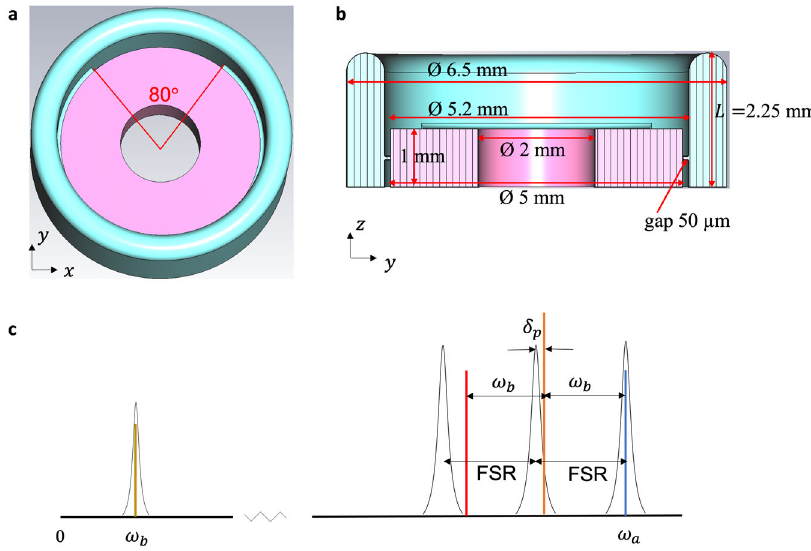
Fig. 1 Three-dimensional superconducting RF (SRF) cavity and electro-optic design for quantum transduction. a Top view of the SRF cavity enclosing a bulk lithium niobate (LN) optical resonator (pink). The cyan region refers to the vacuum volume enclosed by the niobium (Nb) (not visible). The LN resonator has a hole (grey) in the center with a 2 mm diameter which is fi lled with Nb. b Side view of the cross- section of the RF cavity with the enclosed LN resonator. L is the length of the stub, which is used to tune the resonant frequency. c Diagram of the three-wave mixing process for microwave-optical quantum transduction. The optical pump is injected into the optical resonator. The pump is detuned by δ p from the central optical mode. Mixing of the optical pump and the weak microwave signal at frequency ω b generates two optical sidebands (red and blue). The blue sideband signal excites the optical mode at ω a , whereas the red sideband signal is off- resonance and inhibited. Reversely, by mixing the optical pump and the optical signal at ω a , microwave photons at ω b are coherently generated. Thereby, this scheme enables bidirectional conversion between the microwave fi eld at ω b and the optical fi eld at ω a optical fi eld in the LN crystal structure and the microwave fi eld.